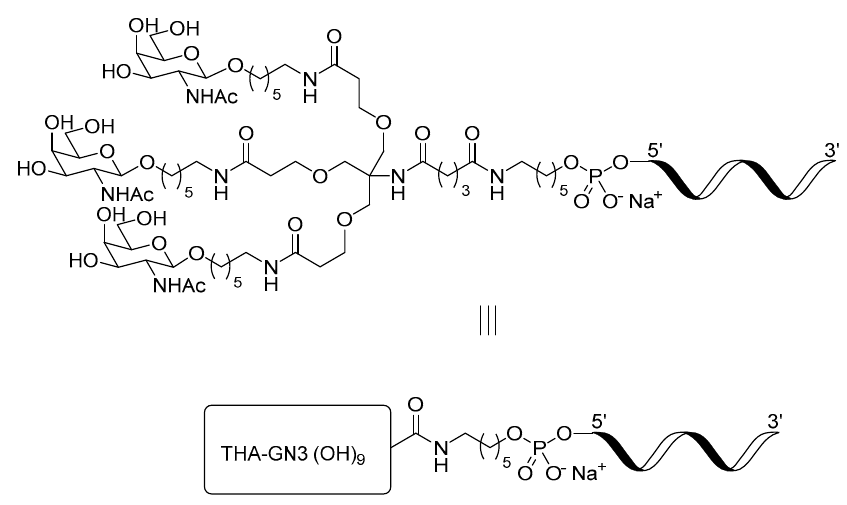
Figure 1. Structure of the GalNAc-ASO conjugate.